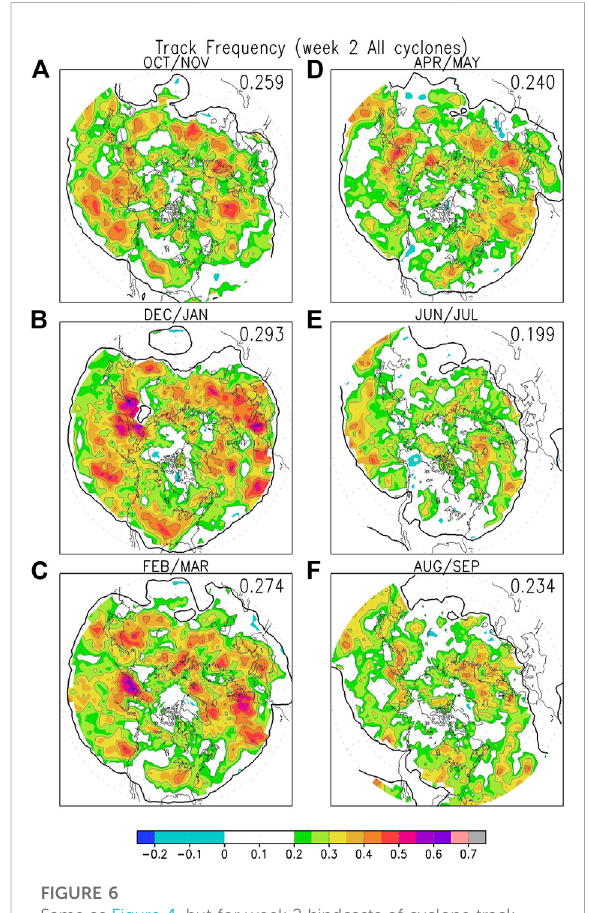
FIGURE 6 Same as Figure 4, but for week 2 hindcasts of cyclone track frequencyofallcyclones.Thethicksolidcontourcorrespondstoa cyclone track frequency of 0.1/week.